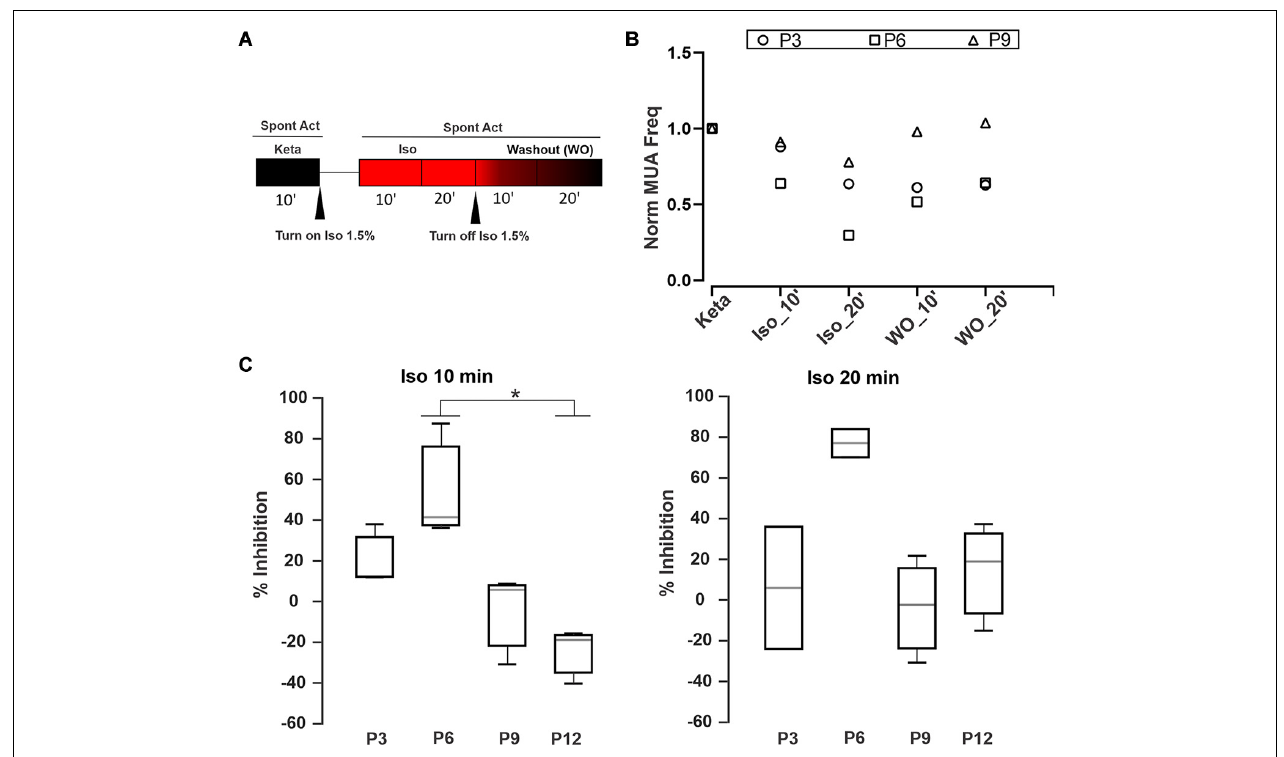
FIGURE 4 | Time-dependent inhibition of Isoflurane. (A) Schematic diagram of the pharmacological protocol for testing Isoflurane inhibition. The first step was to record the spontaneous activity during 10 min under K/X mix (black box). Then we applied Isoflurane 1.5% for 90 s followed by two recording rounds of 10 min to obtain MUA after 10 or 20 min, respectively (red boxes). After that, ISO was turned off to evaluate the washout for the next 20 min. (B) Three examples showing the ISO inhibition and its washout at different developmental ages (P3, P6, and P9). Normalized MUA frequency relative to the K/X mix state (Norm MUA freq). (C) Percentage of Inhibition (MUA frequency under ISO/MUA frequency under K/X mix) after 10 (left) or 20 min (right) with ISO at different developmental stages. Statistical analysis show that ISO at 10 min had a greater inhibition at P6 in comparison with P12 (K-W, p = 0.007; multiple comparisons, * indicates multiple comparisons, p < 0.05; n =